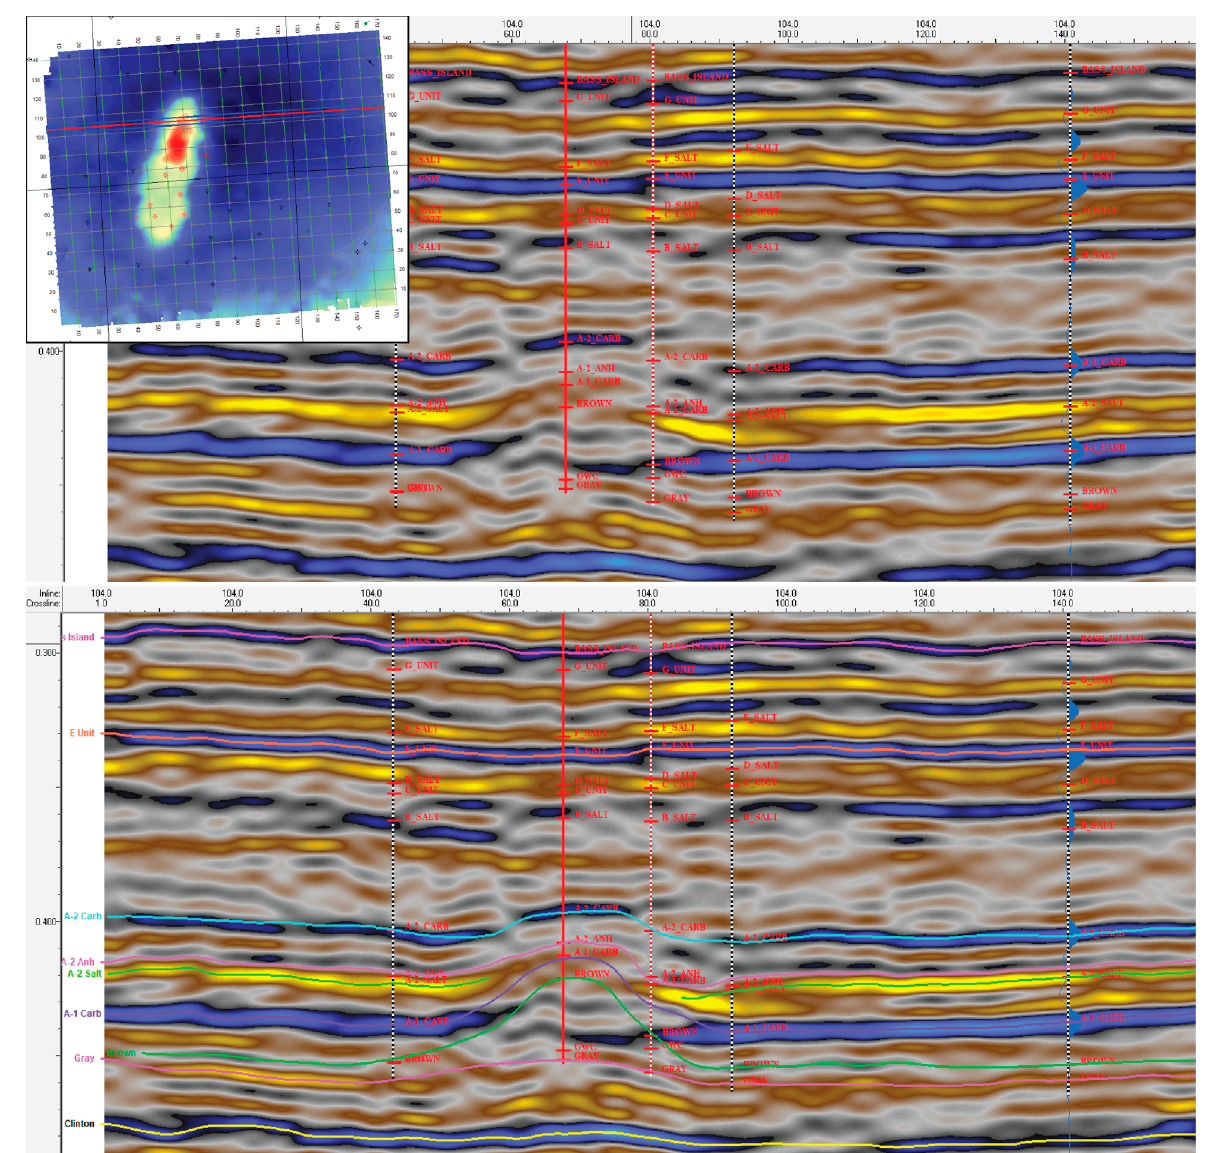
Figure 4. Top image displays inline 104 (east-west direction) without any horizon interpretations but with wells, well tops, and synthetic seismogram displayed. Bottom image has horizon picks added. Warmer colors indicate a negative impedance contrast, while cooler colors indicate a positive impedance contrast. The top image is the inline without interpretation, the bottom is with the horizon interpretation. The A-2 Anhydrite, A-1 Carbonate, Brown, and Gray Formations are very difficult to resolve and require a great deal of apriori geologic and structural knowledge of the area to pick accurately. The A-2 Carbonate and Clinton horizons are much easier to resolve. The A-2 Salt is shown on the flanks of the reef.